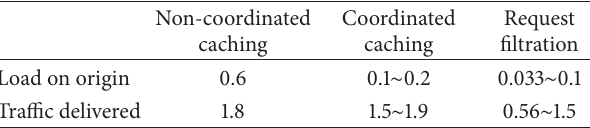
Table 1: Comparing the three edge caching